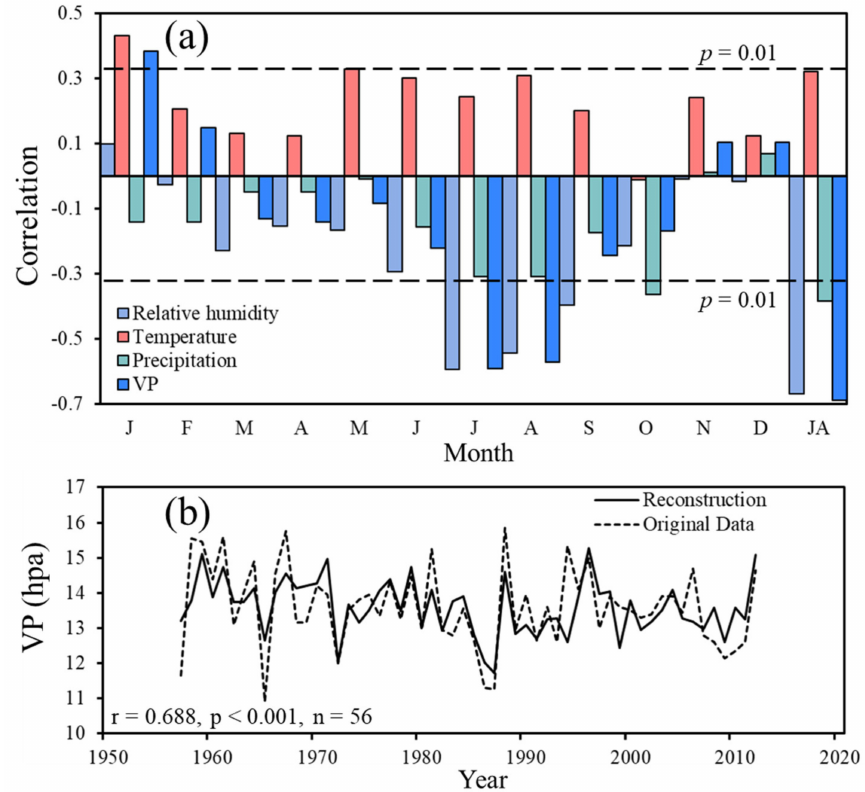
Figure 2. ( a ) Correlations between tree-ring δ 18 O chronology and climatic factors (including rela- tive humidity, temperature, precipitation, and VP). JA represents the period from July to August. ( b ) Comparison between reconstructed and observed July to August VP.